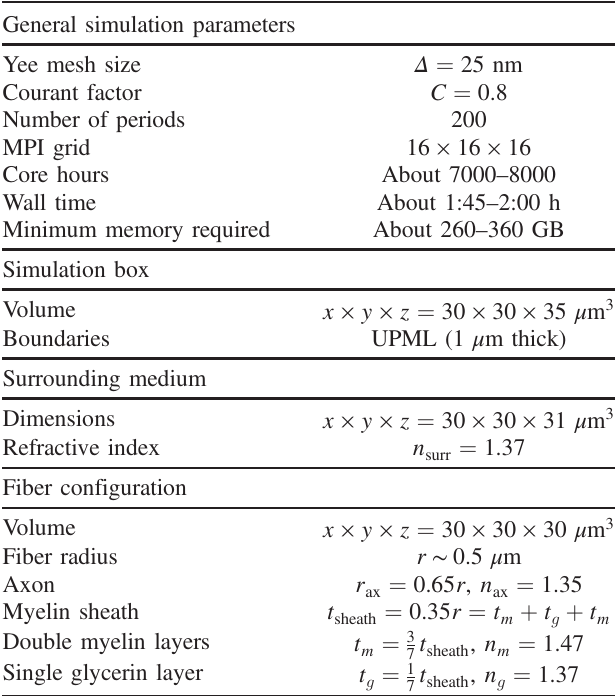
IV: expenses of one simulation run (computation of one fiber configuration, one wavelength, and one angle of incidence on JUQUEEN), dimensions of the simulation volume, and fiber properties (radius r , thickness t , and refractive index n